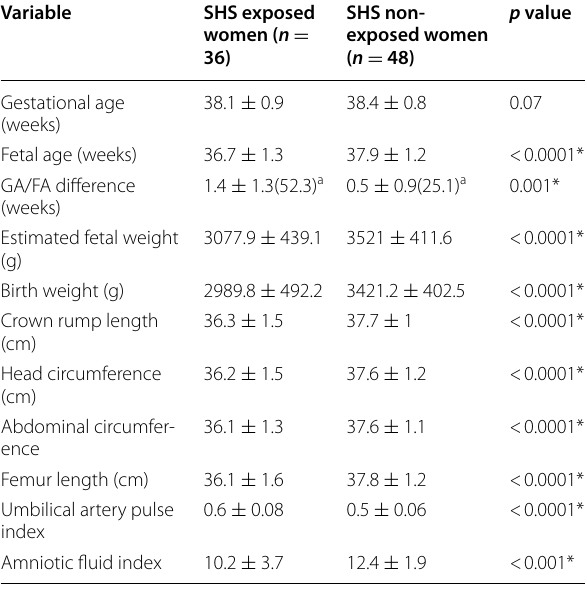
Table 2 Fetal parameters of the current pregnancy outcome in PS exposed vs. non-exposed pregnant